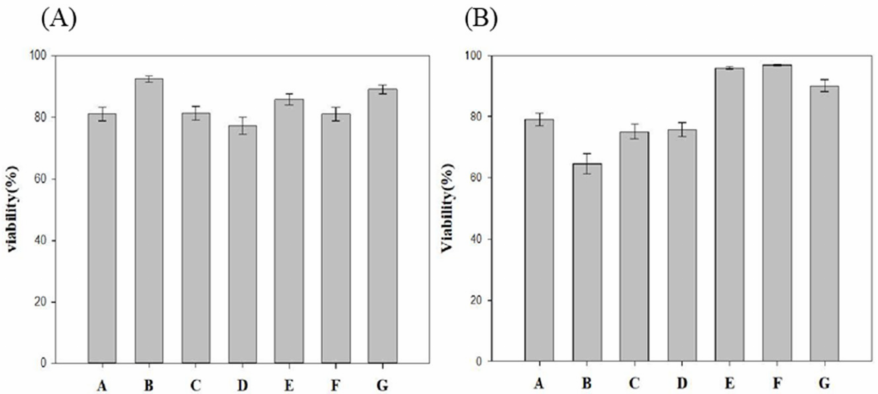
Figure 3. Biotoxicity testing using the MTT assay of different cosolvents with 25 wt% mPEG-PLCL on ( A ) Day 1. ( B ) Day 2. Groups A–G are described in Figure